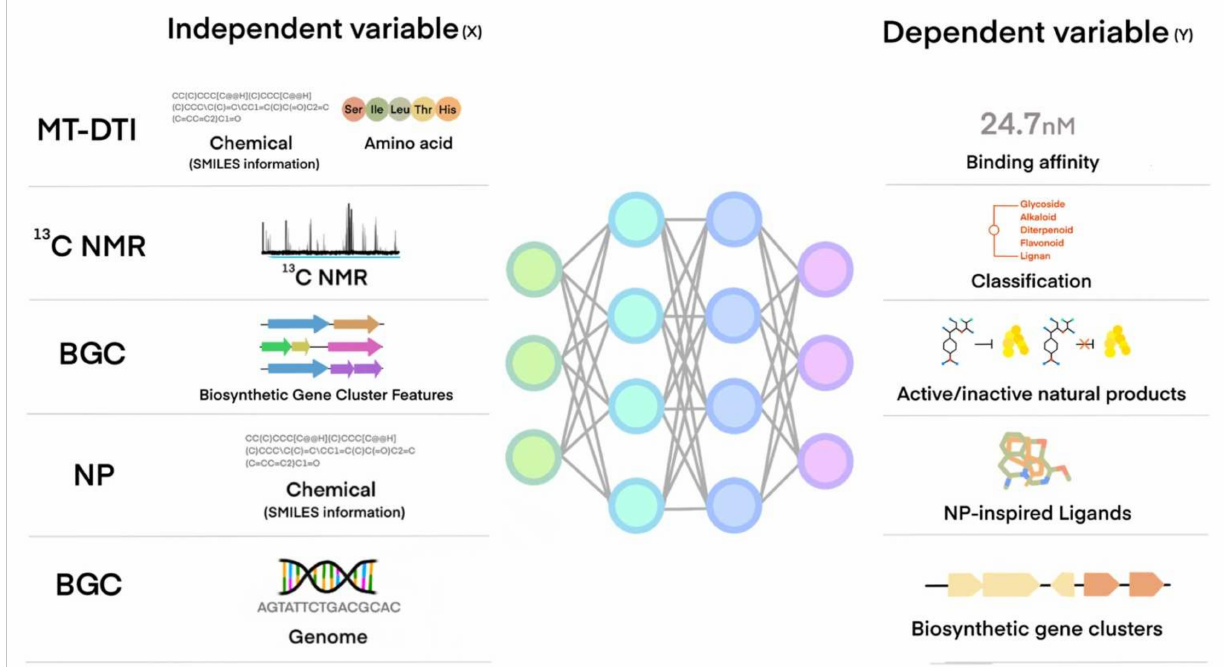
Figure 2. Machine learning-based models have been developed for different purposes. Various input data were used as independent variables (X, left panel) to predict dependent variables (Y, right panel). Five different examples are shown. The first example shows a model (called MT-DTI) that can predict the binding affinity (Y, the equilibrium dissociation constant known as K D ) between a given protein and ligand (small chemical compound). Strings of protein (amino acids) and ligand (SMILES) information (X) are used as input. The second model takes NMR data (X) as input and classifies them into known NP classes (Y). The third model analyzes genomic sequences called biosynthetic gene clusters (X) and predicts the likelihood that a natural product will have activity (Y) from those gene clusters. The fourth model takes a SMILE of a chemical of interest (X, e.g., natural product) and identifies similar small chemicals (Y) with desired multi-target profiles on disease-related targets. The last model detects biosynthetic gene clusters (Y) using a deep learning model called DeepBGC. Bacterial genome sequences are used as input